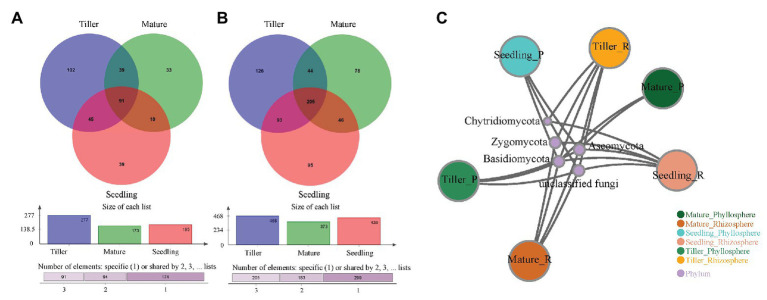
Venn diagram for phyllosphere (A) and rhizosphere (B) fungal communities and the network analysis on phylum level (C) among plant development processes. Numbers indicated shared unique operational taxonomic units (OTUs) at 0.03 dissimilarity distances after removing singletons involved.